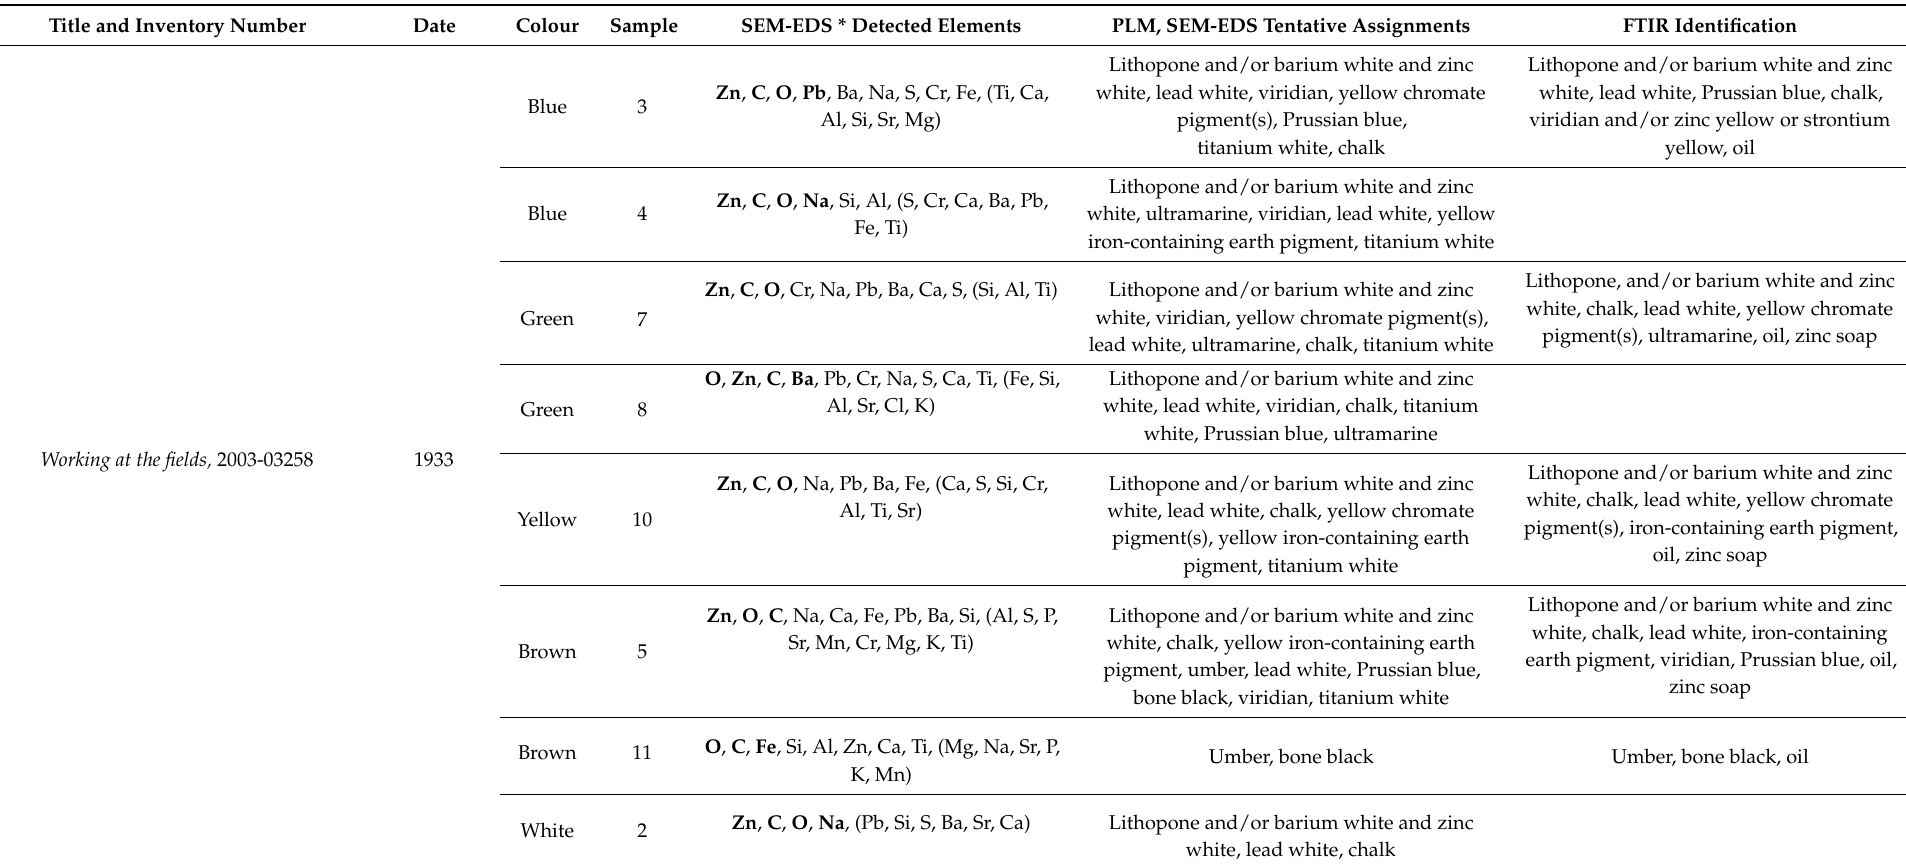
Table A1. Summary of the materials identified or tentatively determined in the paint samples obtained from the investigated